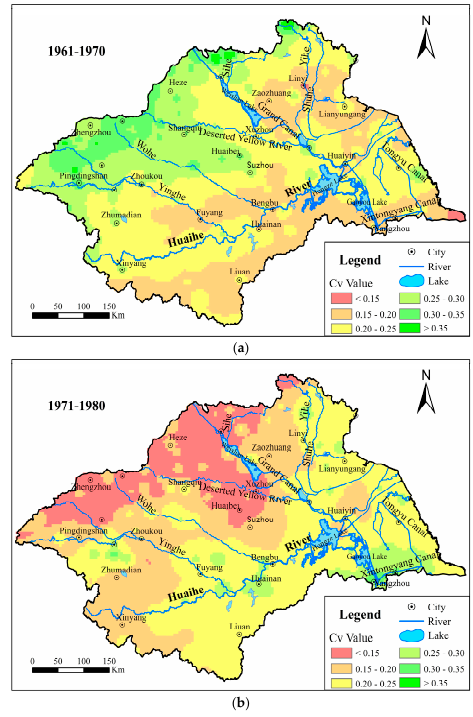
Figure 4. The spatial distribution of the tendency magnitude in the different decadal precipitation (( a ) from 1961 to 1970; ( b ) from 1971 to 1980; ( c ) from 1981 to 1990; ( d ) from 1991 to 2000 and ( e ) from 2001 to 2011).